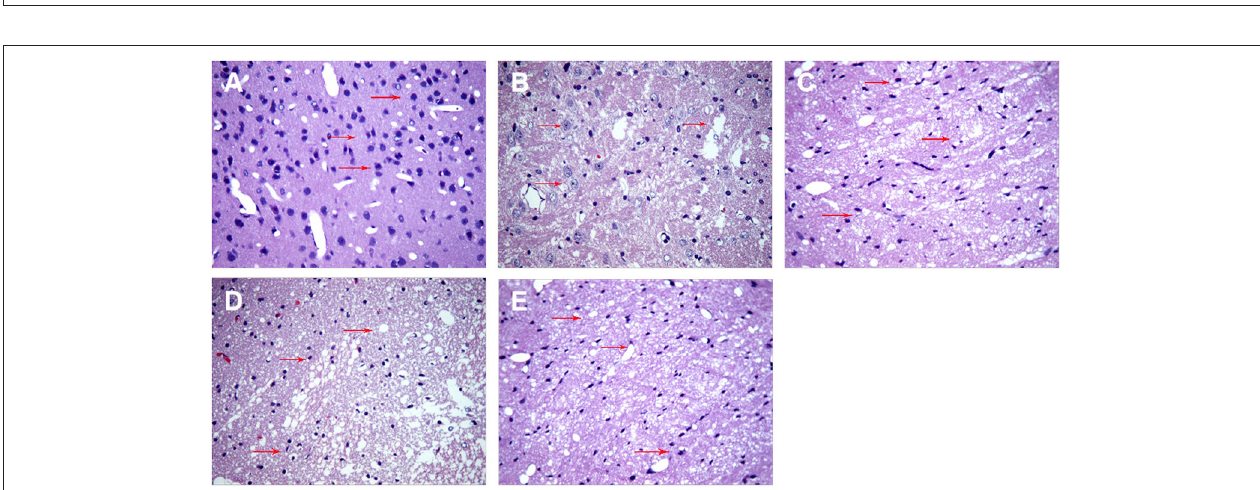
FIGURE 3 | Effect of SA on composite neurological scale score in a rat model of ICH. The results show that SA improves neural function score after ICH in rats. Neuronal function was analyzed in seven behavioral tests. Animals were scored on a scale of 3–21, where lower score indicated more severe neural defect. Data are mean ± SD ( n = 6). Intergroup differences were analyzed using one-way ANOVA and the Student-Newman-Keuls test. * p < 0.05, vs. sham; # p < 0.05, vs. ICH; 1 p < 0.01 vs. SA. ICH, intracerebral hemorrhage; SA, scalp acupuncture; 3-MA, 3-methyladenine.